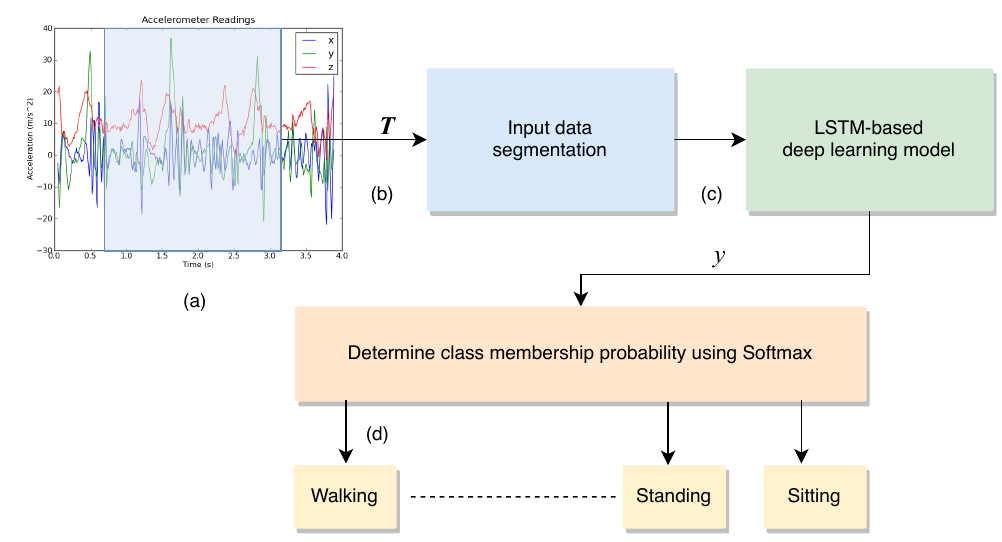
Figure 2. A schematic diagram of the proposed LSTM-based deep learning model for activity recognition system works as following ( a ) the inputs are raw signals obtained from acceleration sensors, ( b ) segment into windows of length T , ( c ) fed into LSTM-based deep learning model, ( d ) and finally, the model outputs class prediction for each time